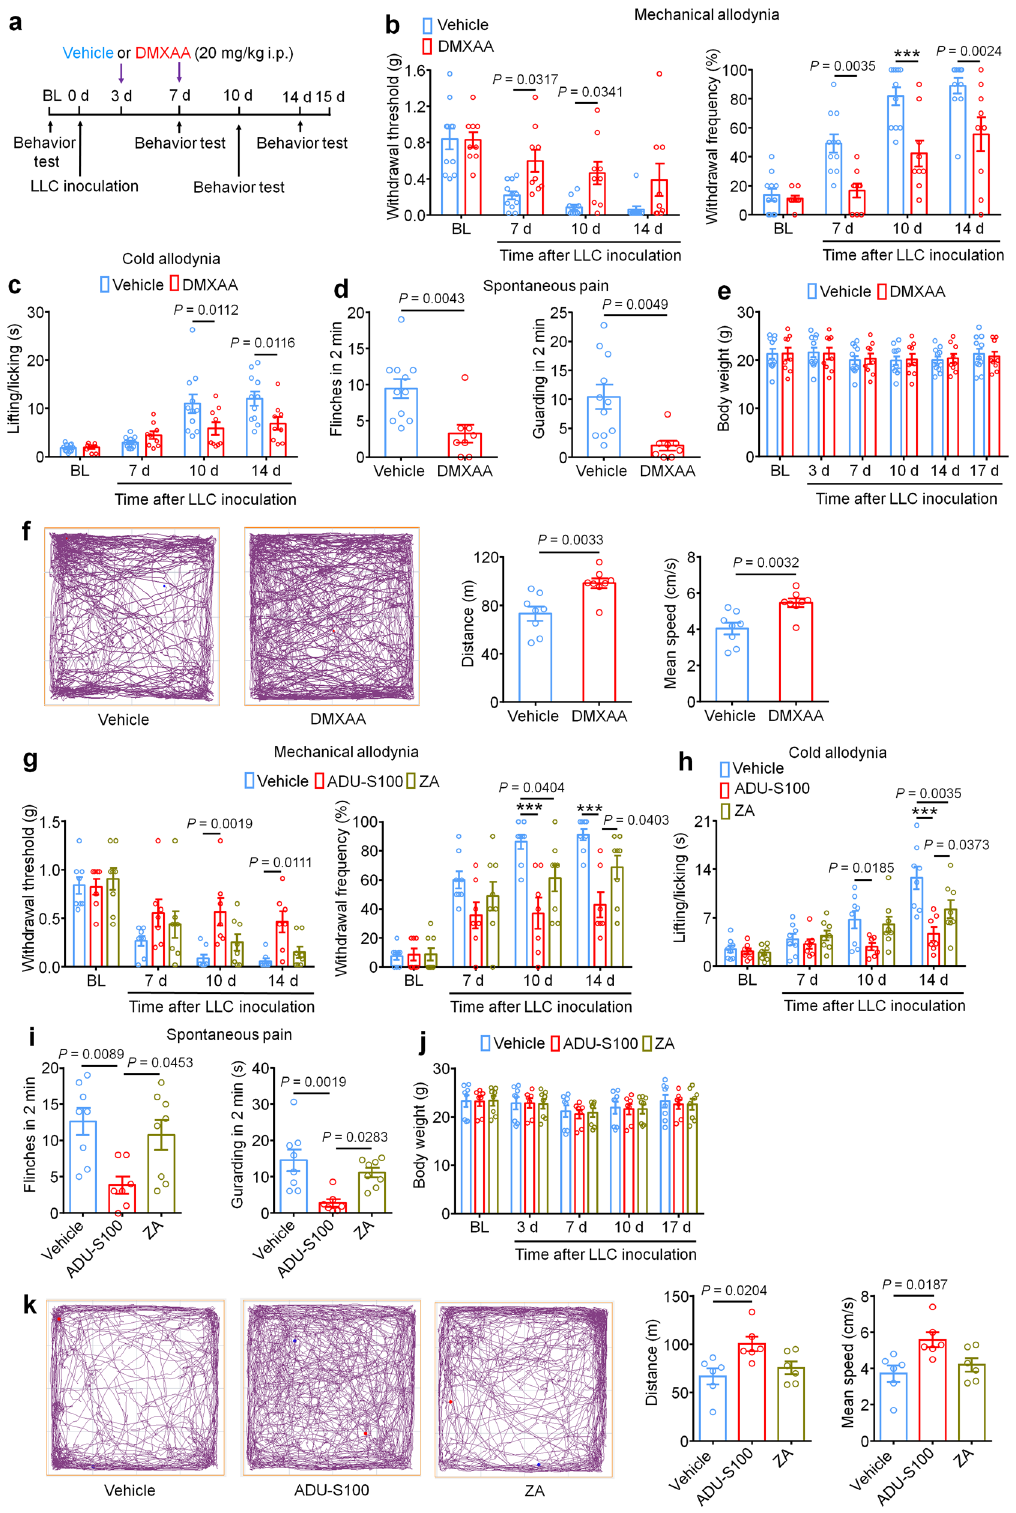
group on d14 (Fig. 1h). In addition, mice treated with ADU-S100 but not ZA exhibited reduced spontaneous and ongoing pain compared to vehicle-treated mice (Fig. 1i). We found that these doses of ADU-S100 and ZA again had no effect on overall body weight (Fig. 1j), suggesting they are relatively safe and without gross GI toxicity. To again assess the potential bene fi ts of ZA and ADU-S100 on function and mobility, we performed open fi eld